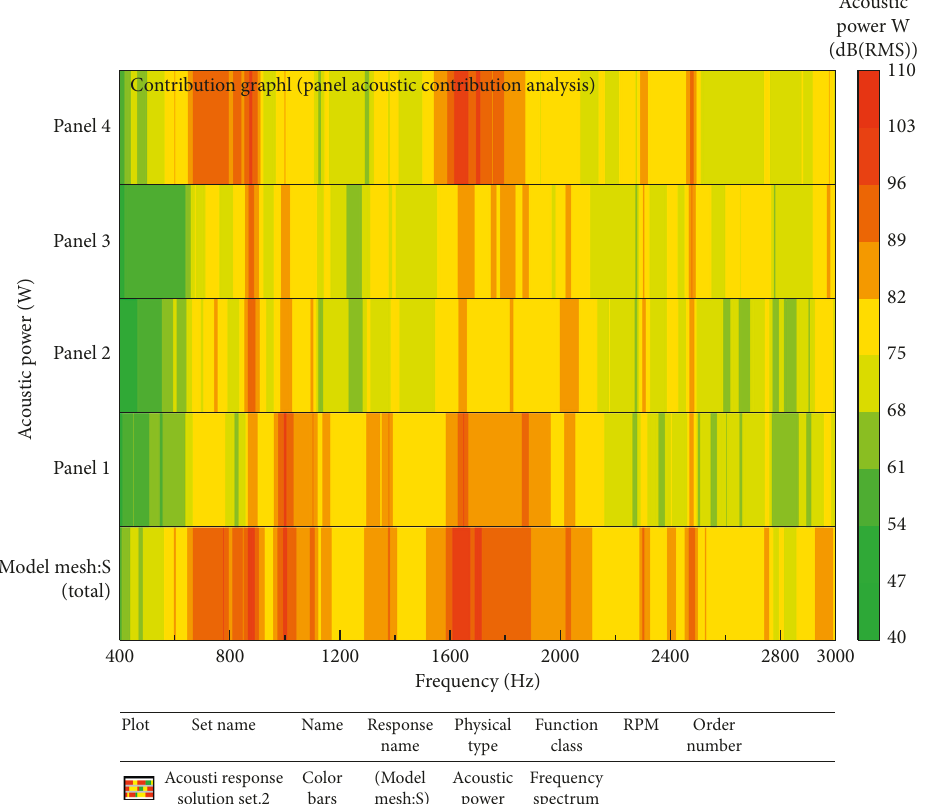
Figure 12: Color map of the panel acoustic power